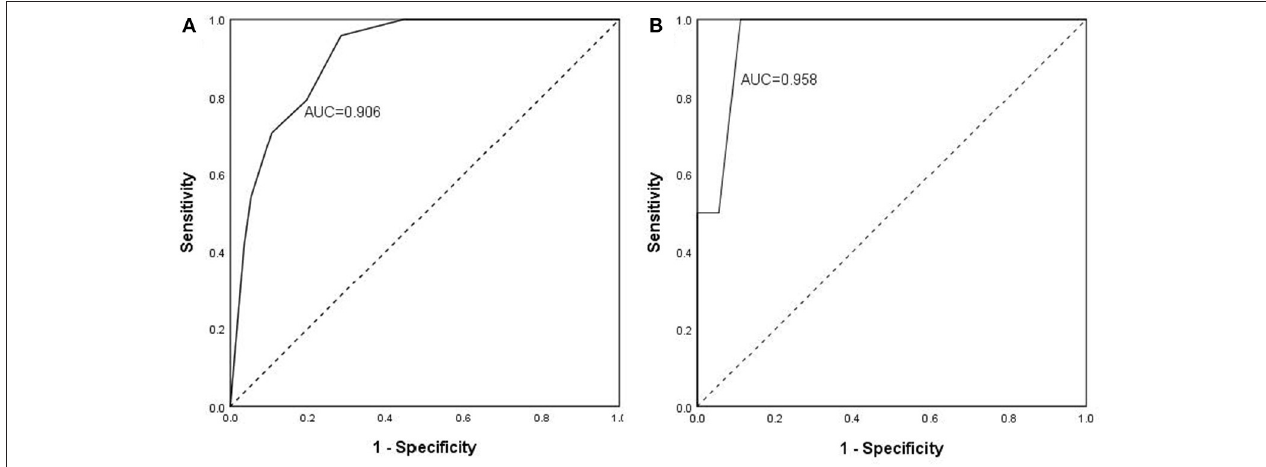
FIGURE 1 | Predictive value and validation of scoring system to the severity of COVID-19. The scoring system was brought into the discovery cohort (A) to calculate the predictive value and found that the accuracy of prediction in severity. AUC is 0.906, sensitivity of prediction is 70.8%, and the specificity is 89.3%. The scoring system was brought into the validation cohort (B) to calculate the predictive value and found that the accuracy of prediction in severity. AUC is 0.958, sensitivity of prediction is 100%, and the specificity is